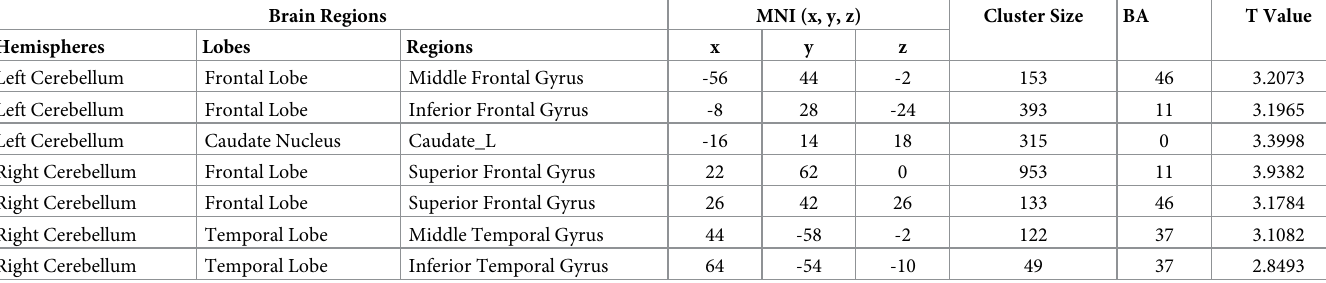
Table 3. Brain areas of significant VBM difference between the breastmilk-fed group and formula-fed